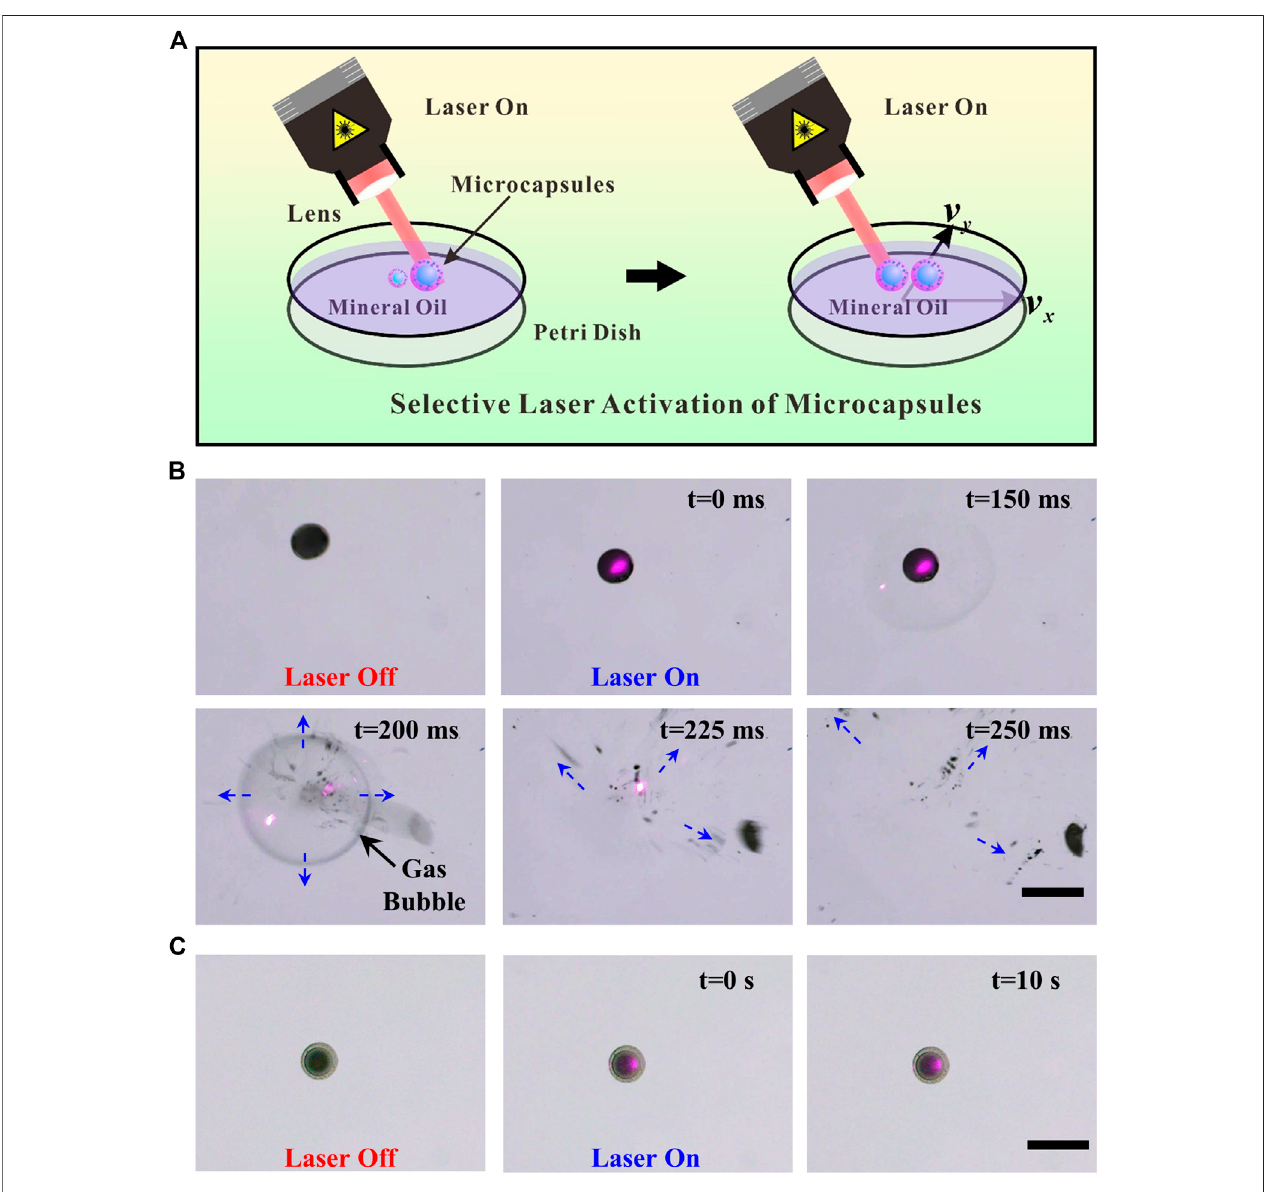
FIGURE 6 | (A) Schematic illustration of the laser activation of PMHMs. (B) Microscopic image of a single PMHM under NIR laser irradiation at different times. (C) Microscopic image of the produced PFC-loaded PNIPAM microcapsules without MNPs in the shell under NIR laser irradiation at different times. Scale bar: 500 μ m.